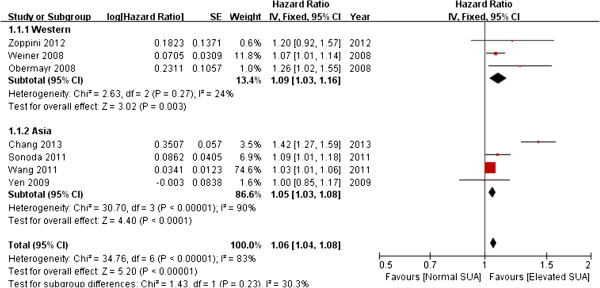
Forest plot of association between SUA and new-onset CKD.